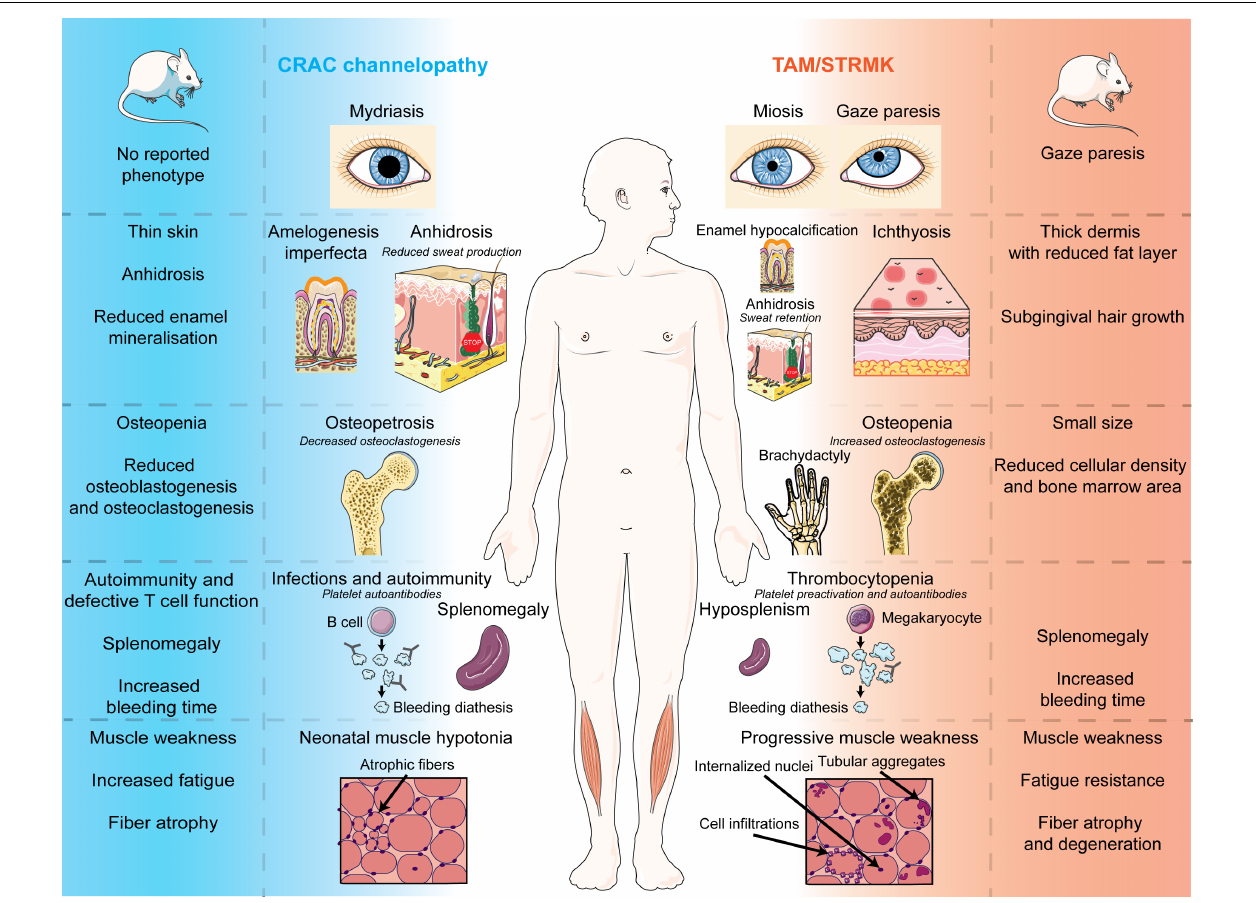
FIGURE 2 | Phenotypes of CRAC channelopathy and TAM/STRMK in patients and mouse models. Schematic overview of the clinical and molecular phenotypes of eyes, skin, teeth, spleen, immune system, and skeletal muscle in CRAC channelopathy and TAM/STRMK. The figure uses modified images from Servier Medical Art Commons Attribution 3.0 Unported License